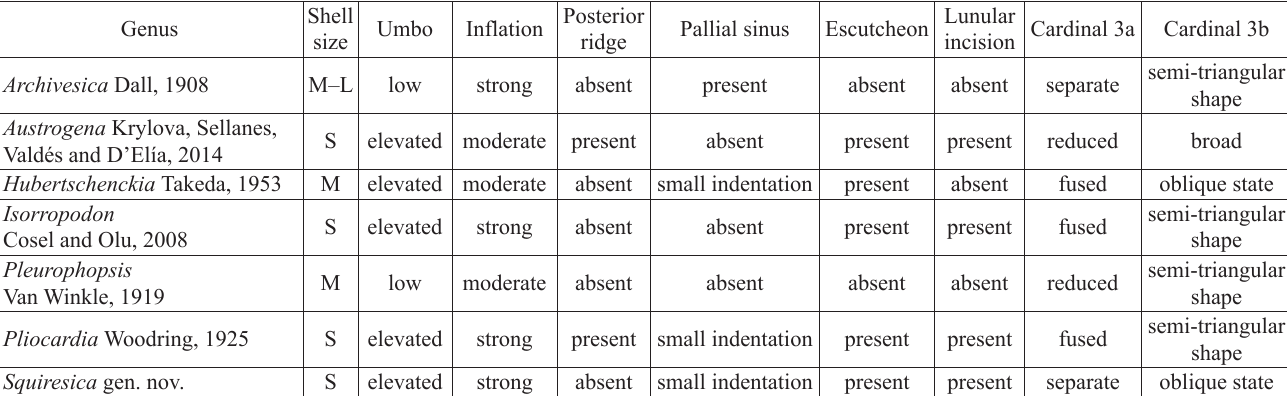
Table 1. Comparison of diagnosable features of the pliocardiin genera discussed herein. Shell size describes the length (L) of the shell: small (S) L <50 mm, medium (M) L 50–120 mm, large (L) L >120 mm. Cardinal 3a has three different character states, it can be separated from cardinal 3b, fused with 3b or reduced which refers to an absent